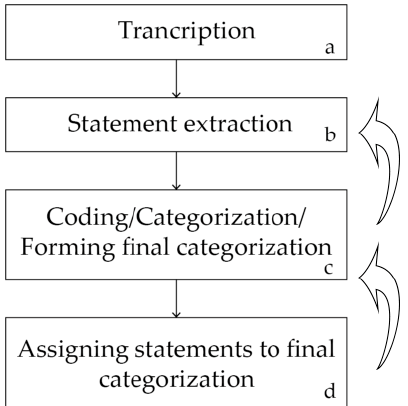
Figure 3. Schematic diagram of content analysis [44].